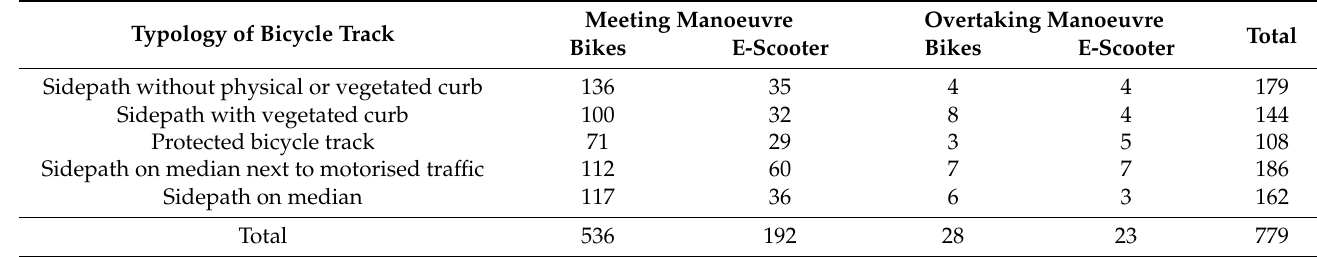
Table 2. Number of involved vehicles during data collection.